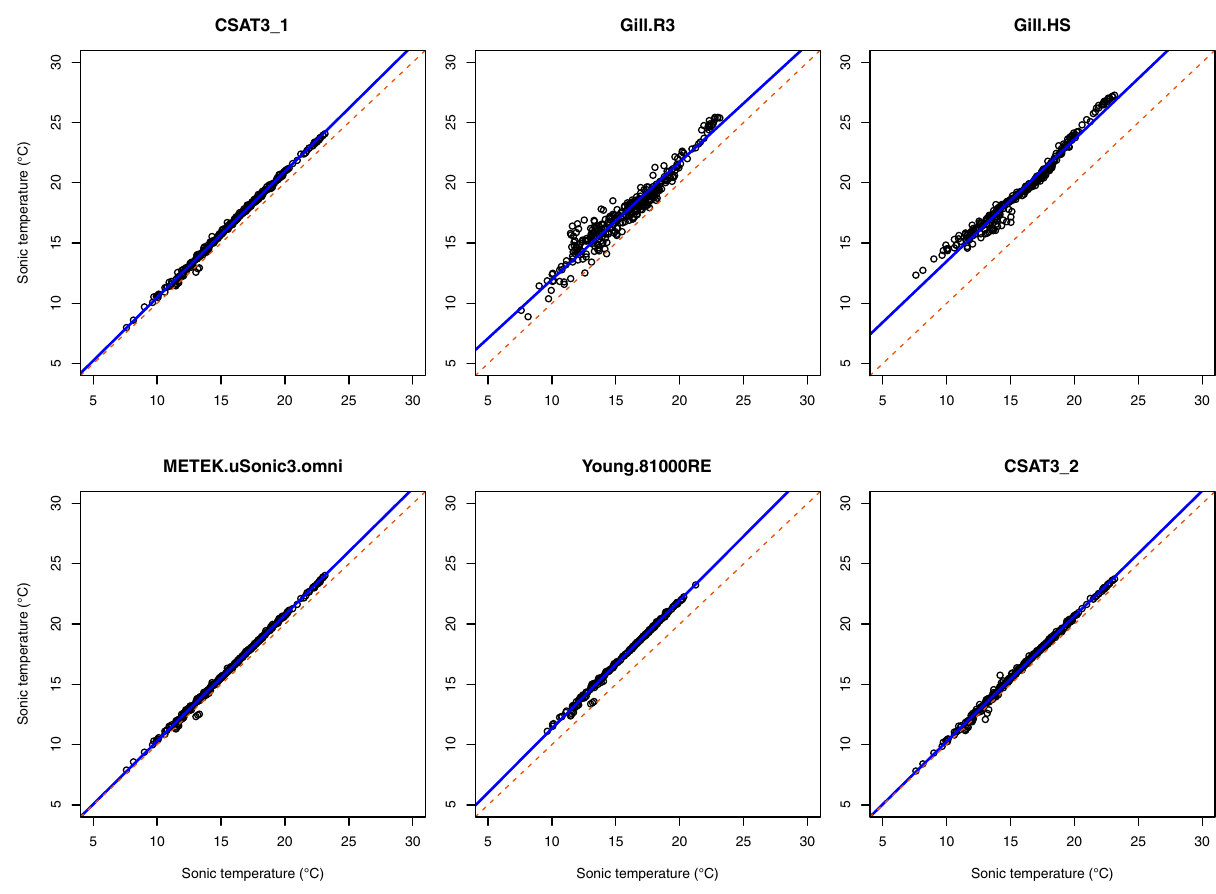
Figure 5. Comparison of the averaged sonic temperature measurements (etalon = Young.81000). Table 3. Regression results for the comparison of mean sonic temperature T s , plus estimates for bias and comparability (RMSE); unusually large deviations from the etalon are in bold (slopes deviating more than 5% from unity and absolute differences of more than 1K). Etalon = Young.81000 CSAT3_1 Gill.R3 Gill.HS Young.81000RE